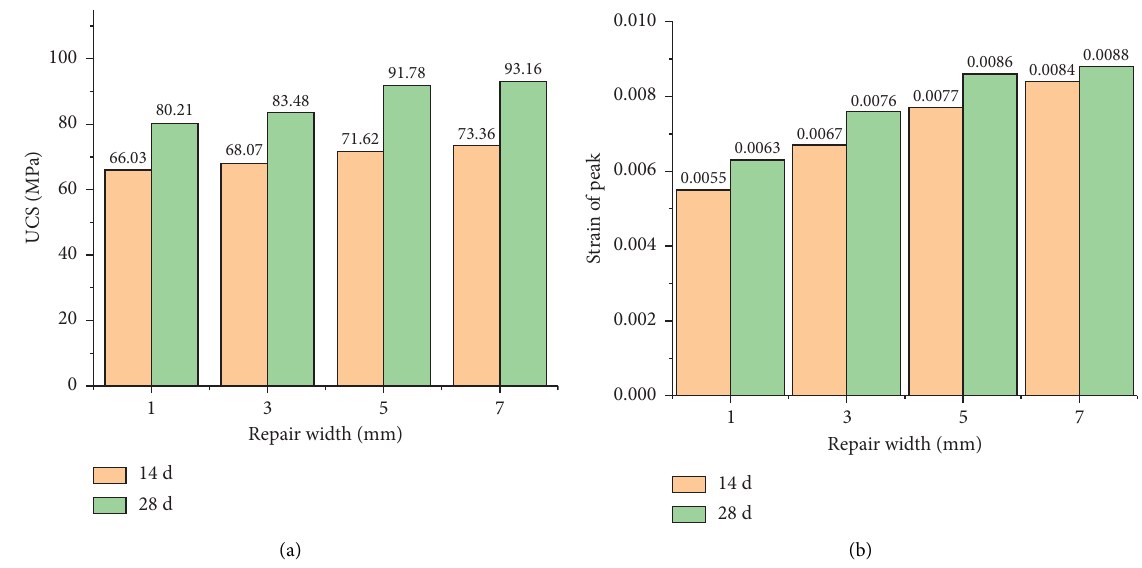
Figure 28: UCS (a) peak strain and (b) for diferent epoxy repair widths at days 14 and 28.